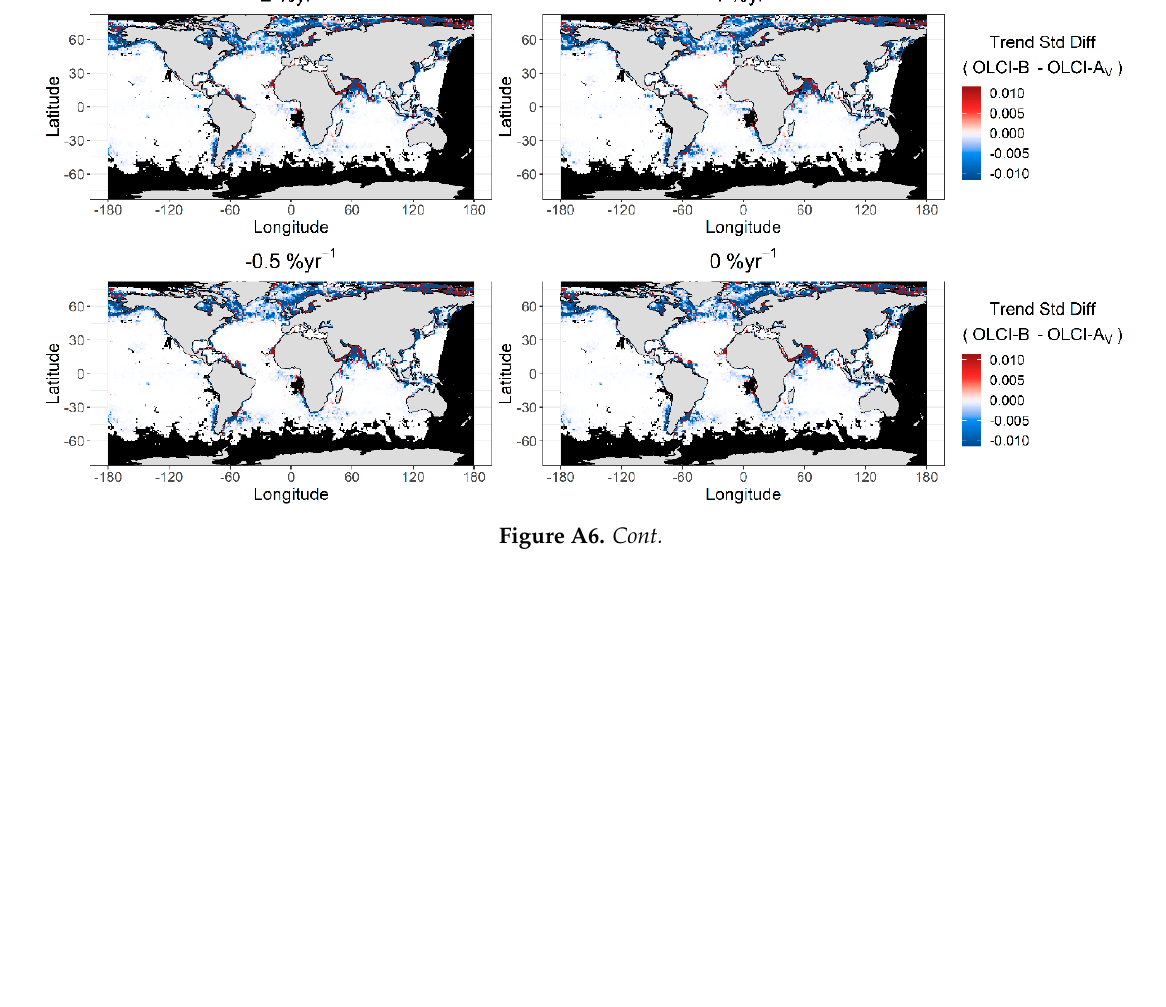
Figure A6. Global 1° maps of the differences between the standard deviation of all chl- a trend estimates from all bootstraps for OLCI-A-Vicarious and OLCI-B in each grid cell. The value expressed in percent per year above each subplot indicates the trend imposed on the synthetic time series. Blue indicates that OLCI-A-Vicarious has higher standard deviation of chl- a trend estimates than OLCI-B. Black grid cells indicate where missing data prevents analysis.